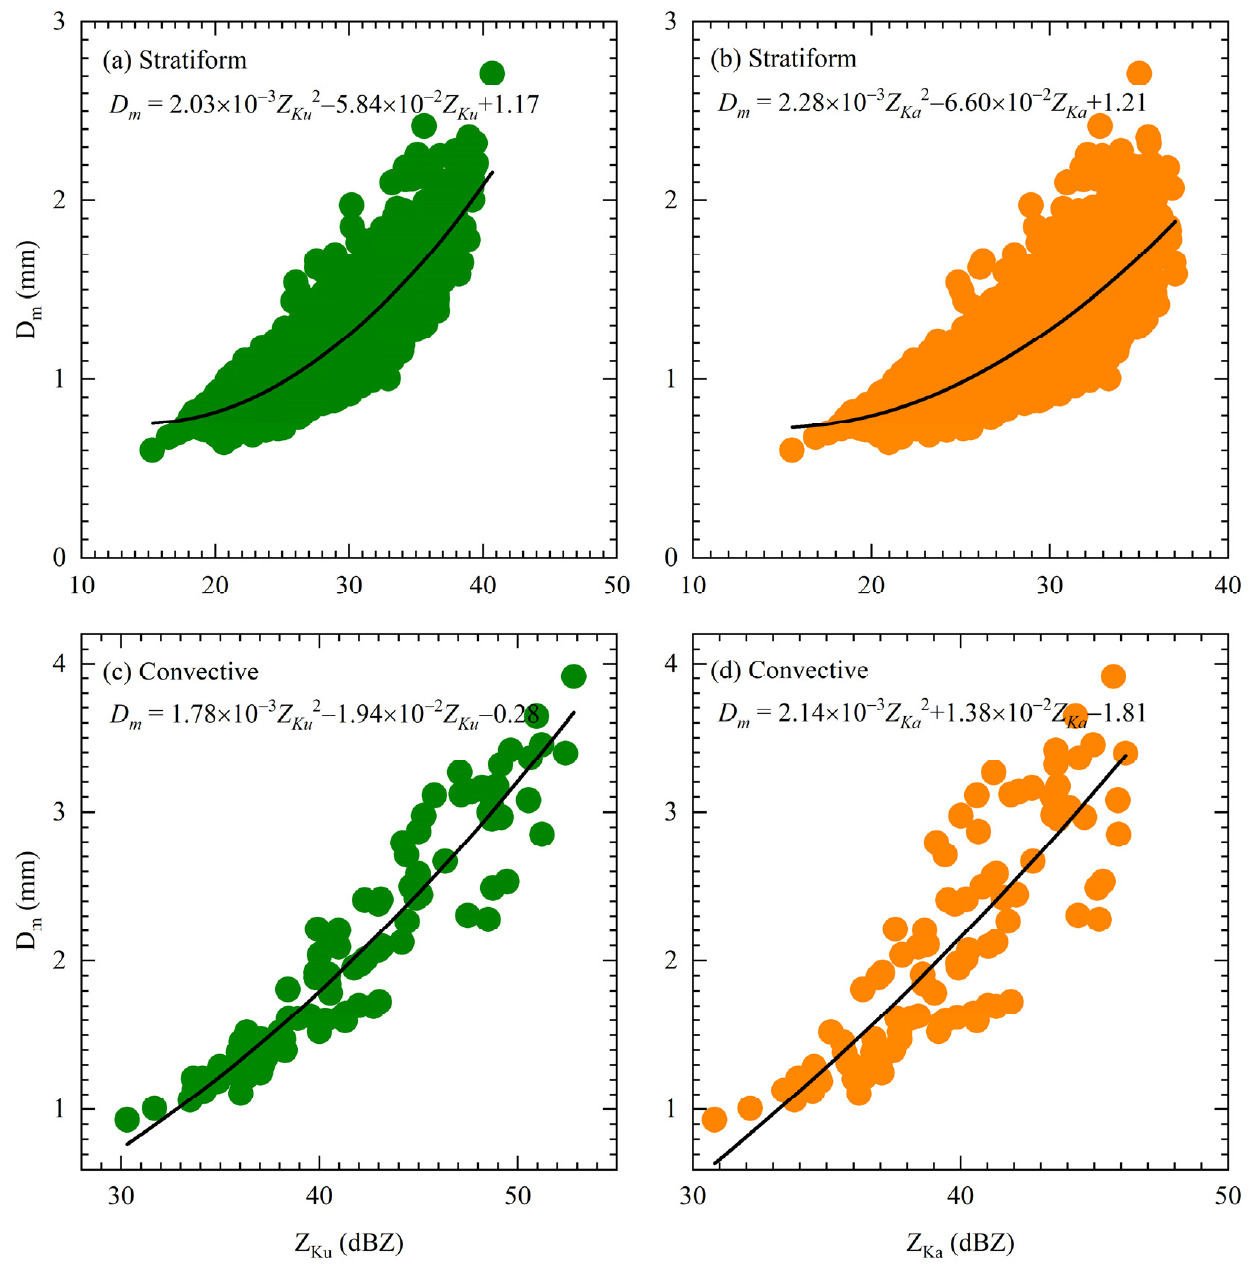
Figure 12. Scatterplots of D m vs. Z Ku and D m vs. Z Ka , and the fitted D m – Z Ku and D m – Z Ka relations for ( a , b ) stratiform and ( c , d ) convective rainfall in Zhaosu.